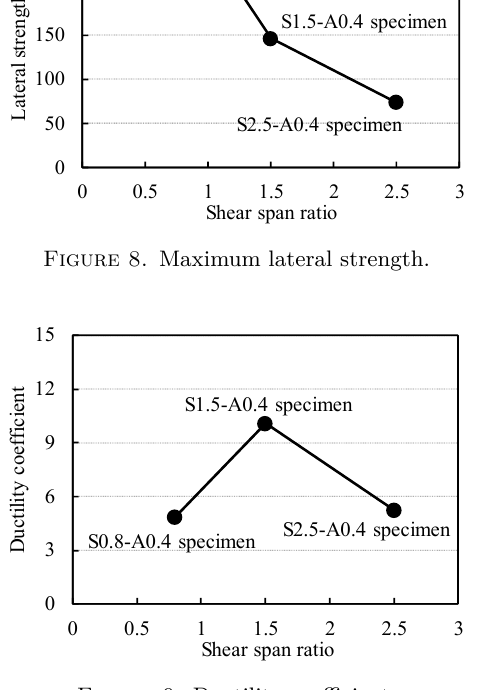
Figure 11. Definition of equivalent damping